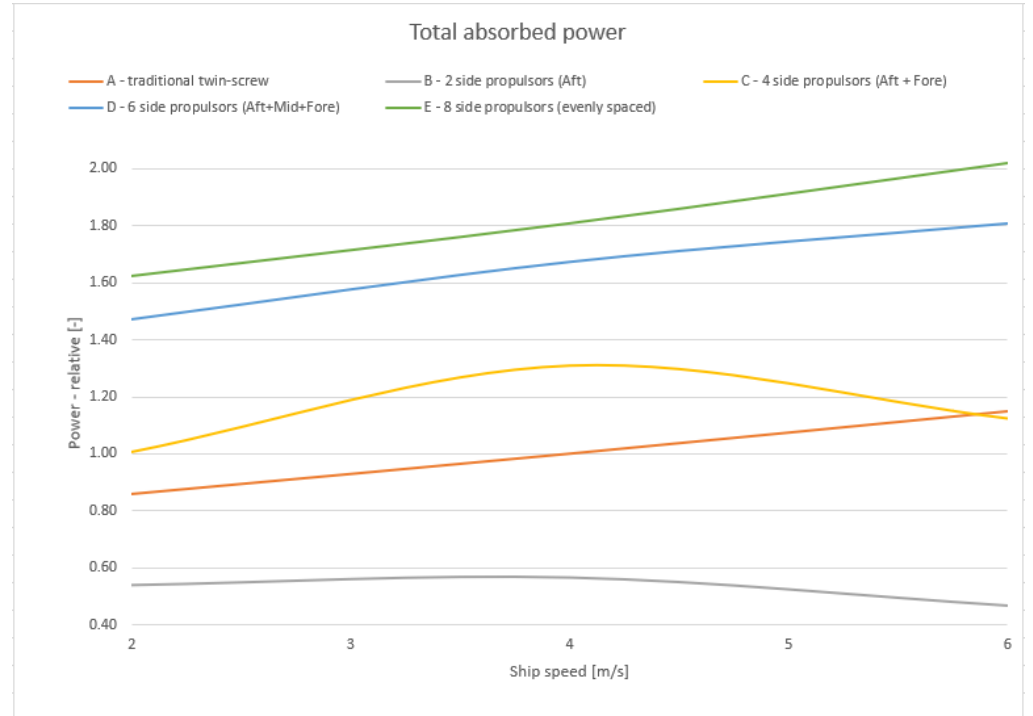
Figure 10. Total absorbed power, deep water (comparison). Source: Authors.